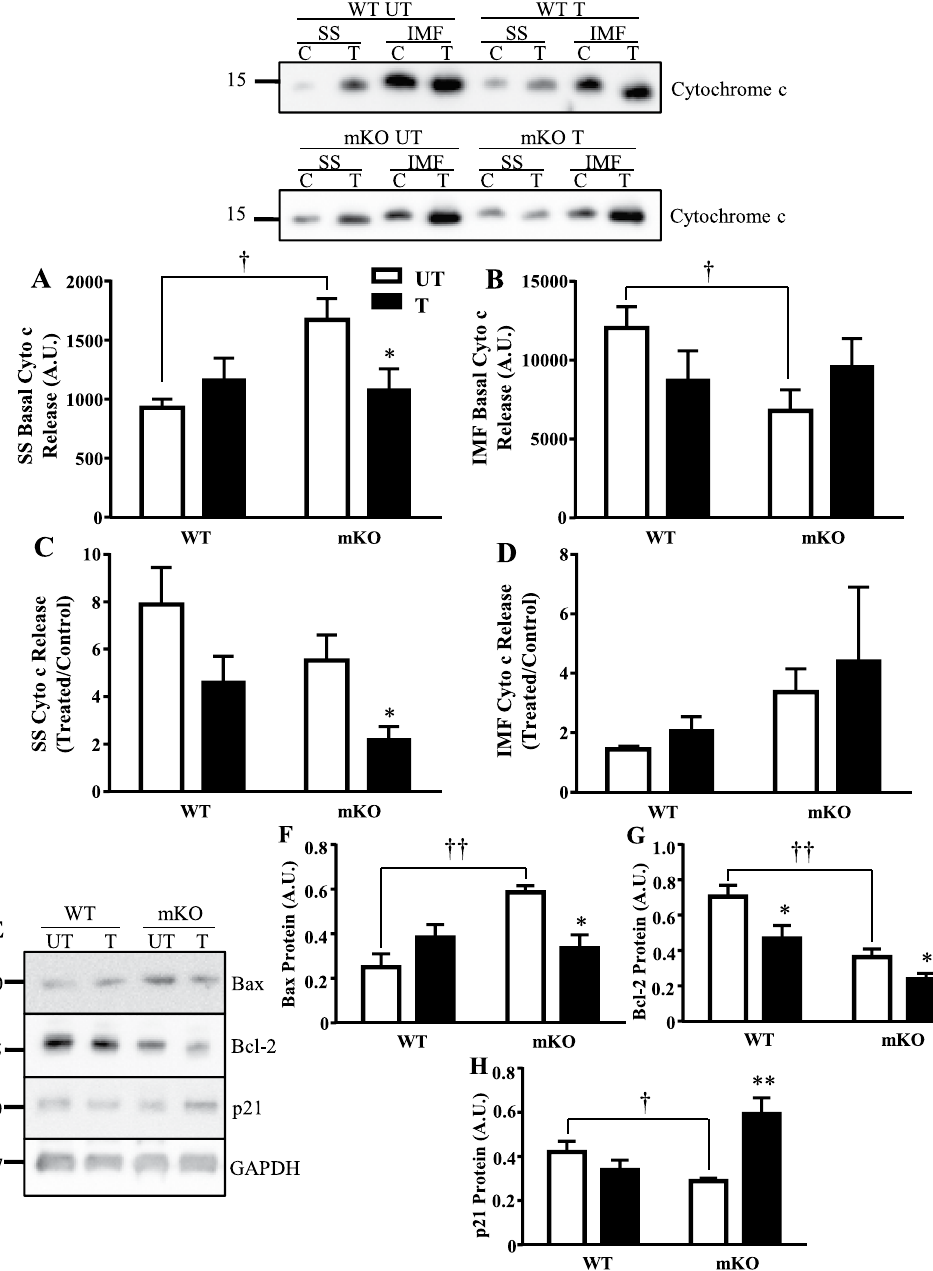
Figure 4. Effect of training and p53 on mitochondrially-mediated apoptosis. In the absence of p53 basally, ( A ) greater cytochrome c release is observed in SS mitochondria with training reducing release (n = 5–8/group); * p ≤ 0.05, UT vs. T, One-way ANOVA; † p ≤ 0.05, UT WT vs. mKO, Student’s t-test, and ( B ) reduced basal release is observed in IMF mitochondria (n = 7–14/group); † p ≤ 0.05, UT WT vs. mKO, Student’s t-test. Under apoptotic stimuli (H 2 O 2 ), cytochrome c release was reduced with training in C ) SS mitochondria (n = 6–10/ group); * p ≤ 0.05, UT vs. T, One-way ANOVA, and ( D ) did not change in IMF mitochondria (n = 6–12/group). ( E ) Apoptosis, anti-apoptosis, and cellular senescent proteins were measured in whole muscle; ( F ) Bax protein (n = 4–6/group); * p ≤ 0.05; UT vs. T; †† p ≤ 0.01, UT WT vs. mKO, 2-way ANOVA; ( G ) Bcl-2 protein (n = 5–8/ group); * p ≤ 0.05, UT vs. T, Student’s t-test; †† p ≤ 0.01, UT WT vs. mKO, 2-way ANOVA; ( H ) p21 cellular senescent protein (n = 5–6/group); ** p ≤ 0.01, UT vs. T, 2-way ANOVA; † p ≤ 0.05, UT WT vs. mKO, Student’s t-test. Data are presented as mean ±